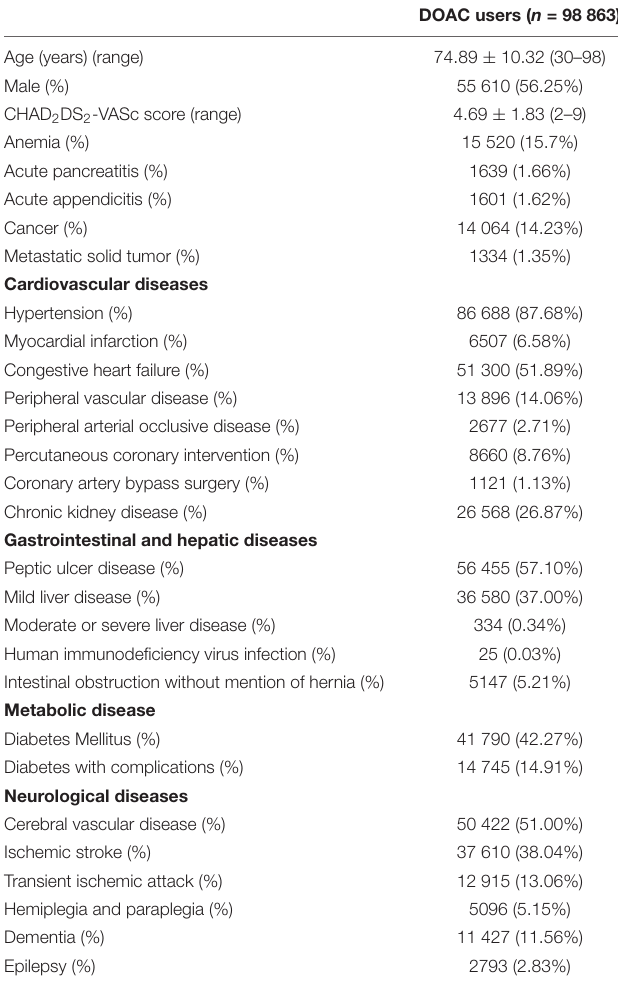
TABLE 1 | Demographic analysis of patients taking direct oral anticoagulants